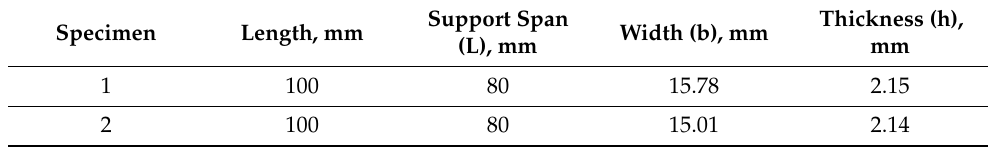
Table 3. Test specimen dimensions.